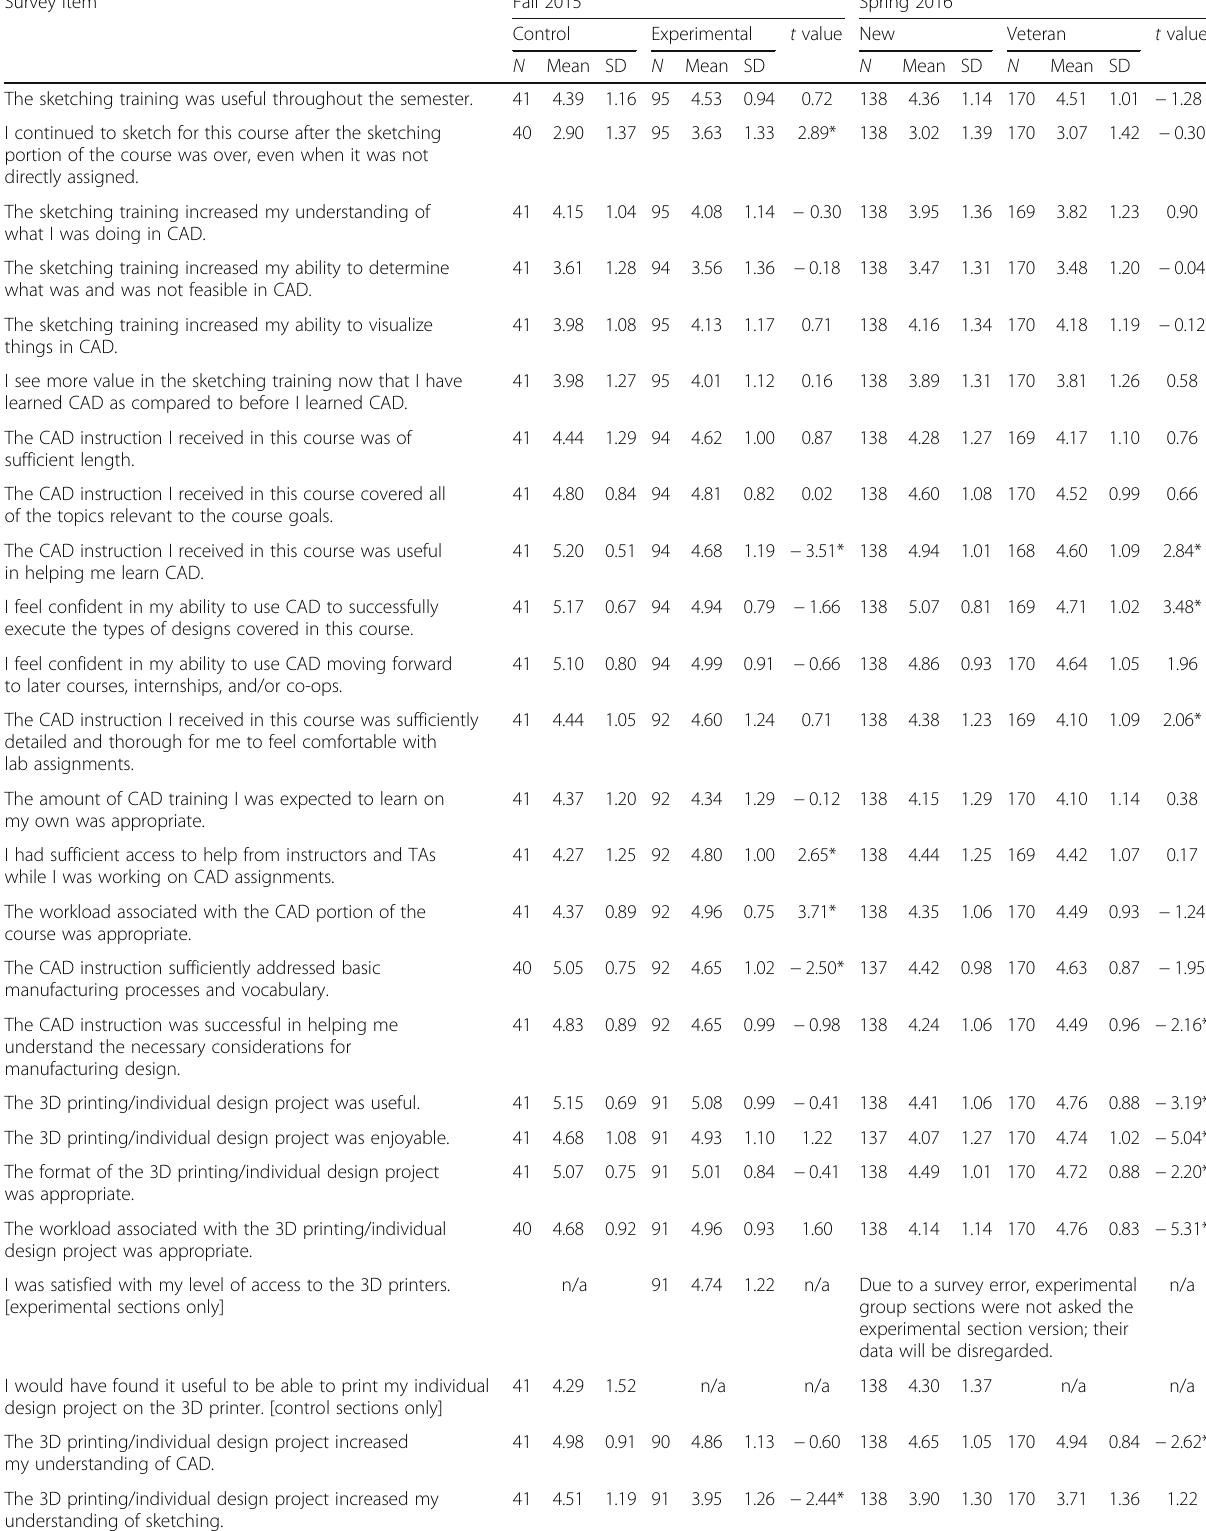
Table 2 End of semester survey results (Fall 2015 and Spring